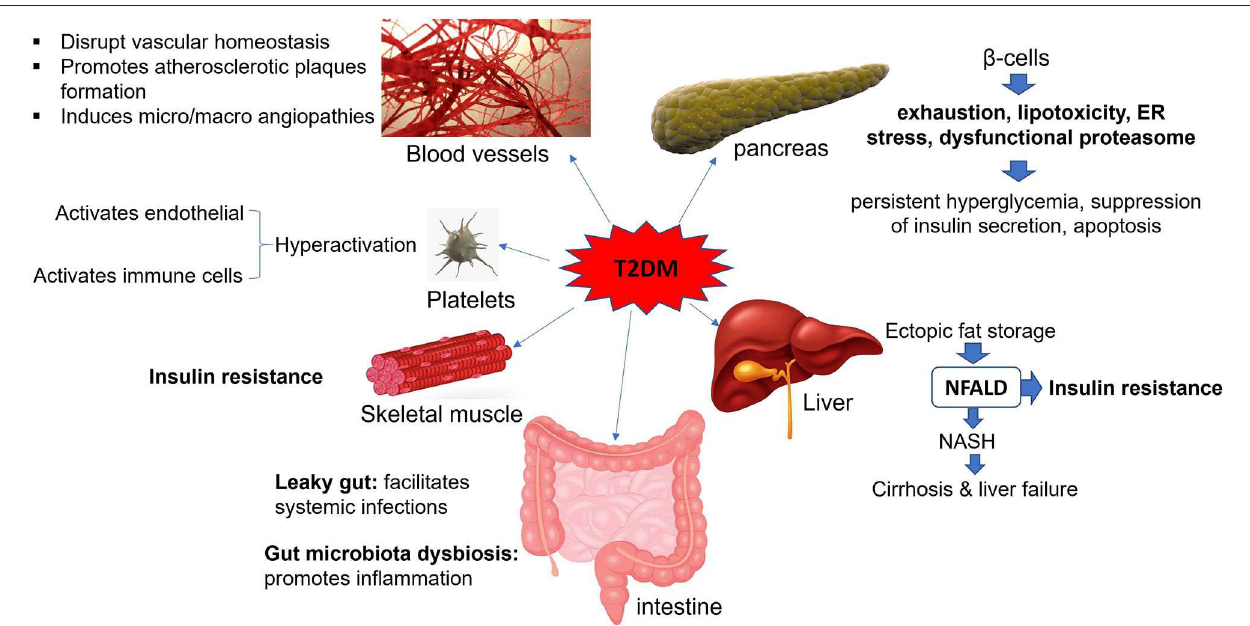
FIGURE 1 | Effects of T2DM on body organs. T2DM is an inflammatory state that affects circulatory system, gastrointestinal tract, pancreatic beta cells, liver, and skeletal muscles and makes them dysfunctional. NFALD, non-alcoholic fatty liver disease; NASH, non-alcoholic steatohepatitis; ER, endoplasmic reticulum.